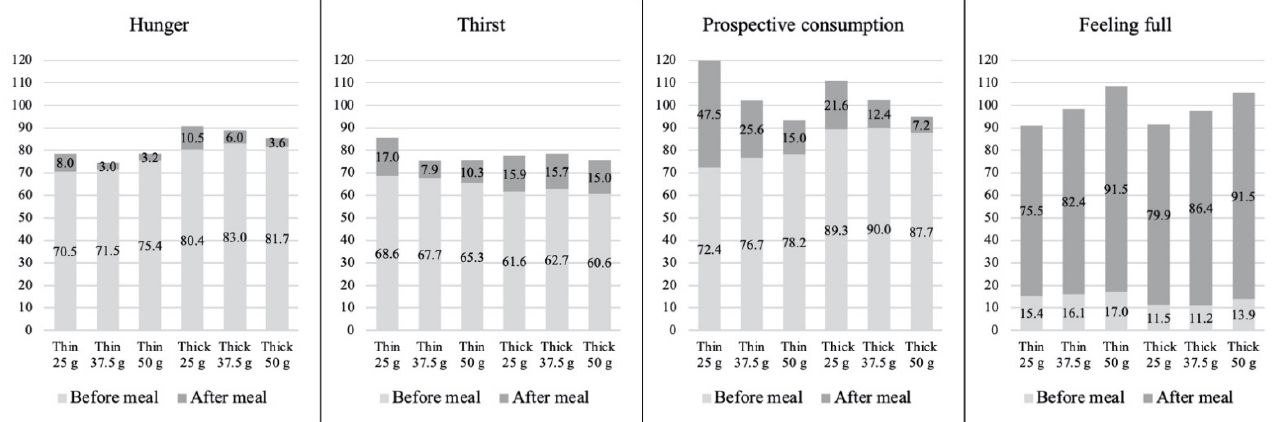
Figure 5. Difference in preferences in relation to the six portion sizes. Repeated measures ANOVA and post-hoc test with Bonferroni correction were used to assess significant differences for hunger after meal for the six preparations of cooked lentils: condition 1 (thin 25 g raw lentils), condition 2 (thin 25 g raw lentils), condition 3 (thin 50 g raw lentils), condition 4 (thick 25 g raw lentils), condition 5 (Before meal thick 37.5 g raw lentils), and condition 6 (thick 50 g raw lentils). Shown are significant differences of VAS scores for the six conditions of daal before and after the meals. Among all significant differences, we noted condition 5 (before meal, thick 37.5 g raw lentils) had the highest mean hunger score, followed by condition 6 (before meal, thick 50 g raw lentils). Condition 5 (before meal, thick 37.5 g raw lentils) had the highest prospective consumption score, followed by condition 4 (before meal, thick 25 g raw lentils). However, condition 12 (after meal, thick 50 g raw lentil) had the lowest prospective consumption score, followed by condition 11 (after meal, thick 37.5 g raw lentils). Condition 9 (after meal, thin 50 g raw lentils) and condition 12 (after meal. thick 50 g) had the highest score for sense of feeling full, followed by condition 11 (after meal, thick 37.5 g raw lentils).